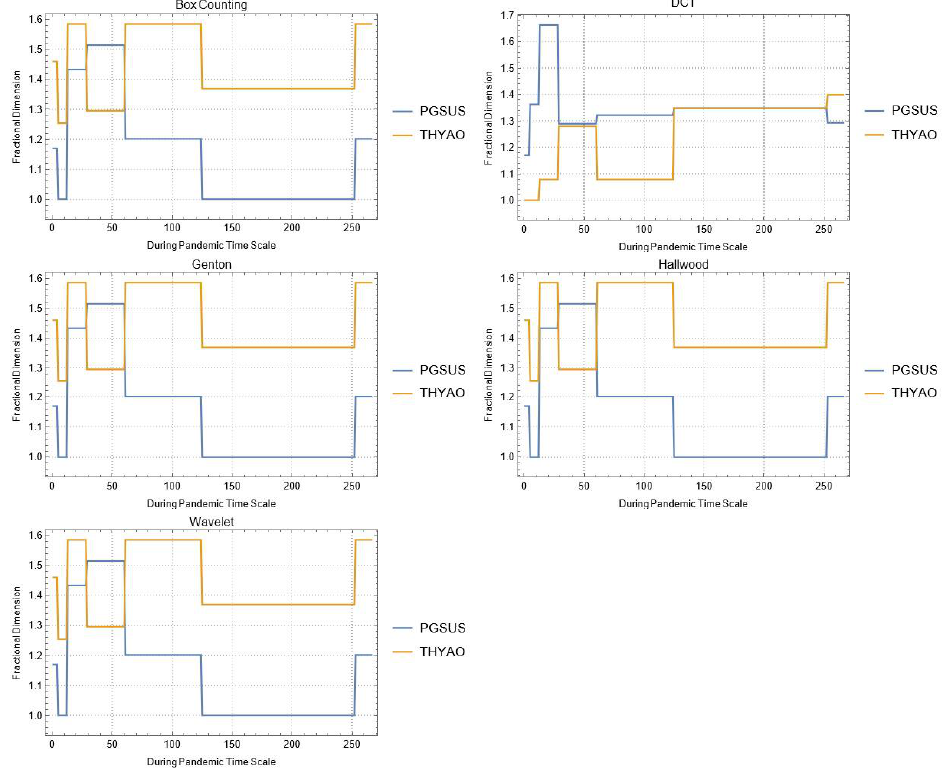
Figure A14. Daily changes of fractal dimensions during the pandemic (transportation).